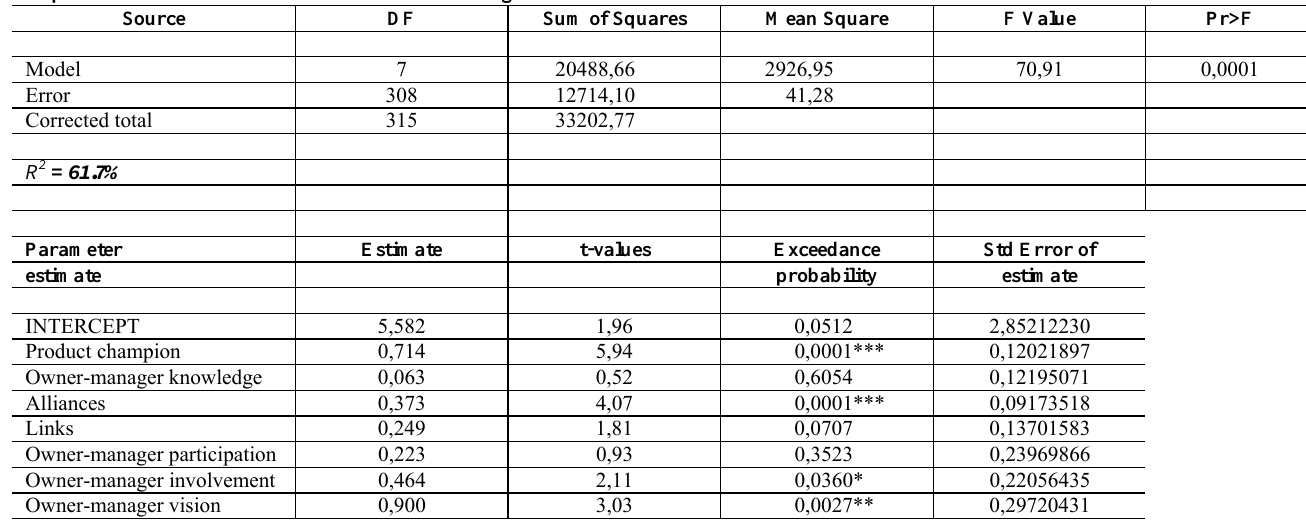
Table 4: Multiple regression results Dependent variable: Successful internet